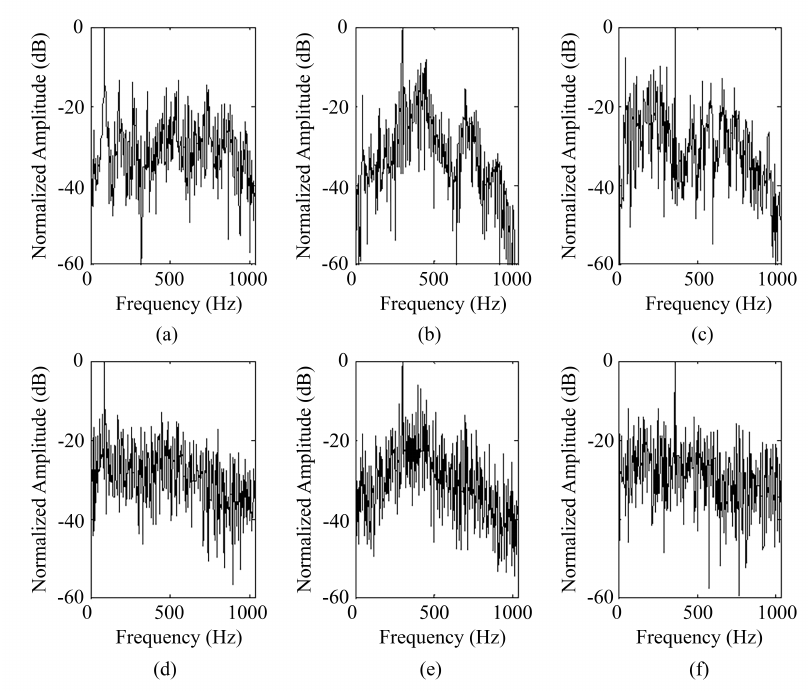
Figure 2. Frequency domain plots of the measured signals with main vibration frequencies ( a ) 90 Hz; ( b ) 296 Hz; ( c ) 360 Hz and the generated signals with main vibration frequencies; ( d ) 90 Hz; ( e ) 296 Hz; ( f ) 360